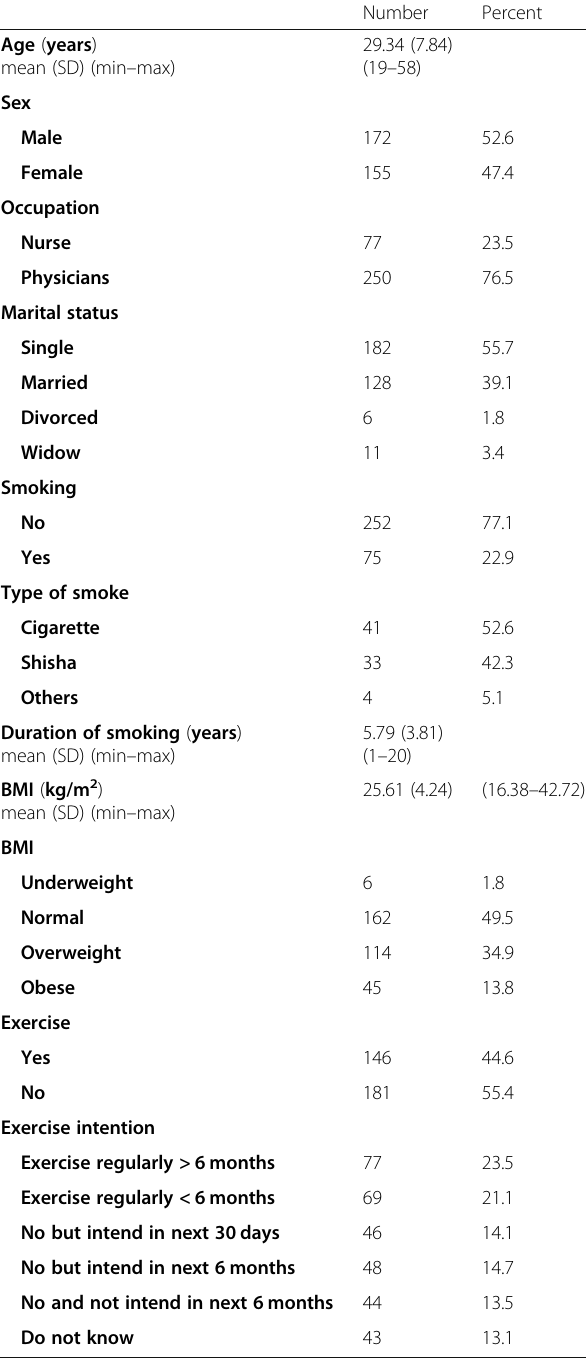
Table 1 Characteristics of healthcare providers ( n = 327),